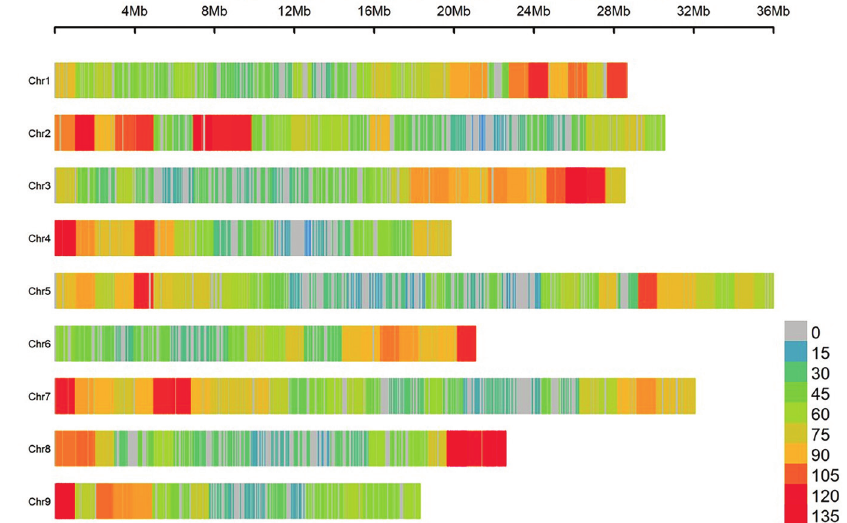
Figure 1 - Density of markers in the chromosomes considering all markers resulting from the SNP technology from